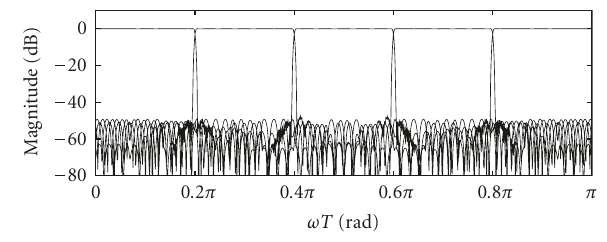
Figure 8: Magnitude response of the distortion function without the nonlinear optimization procedure with N G = 47 and N F = 102, Example 1.